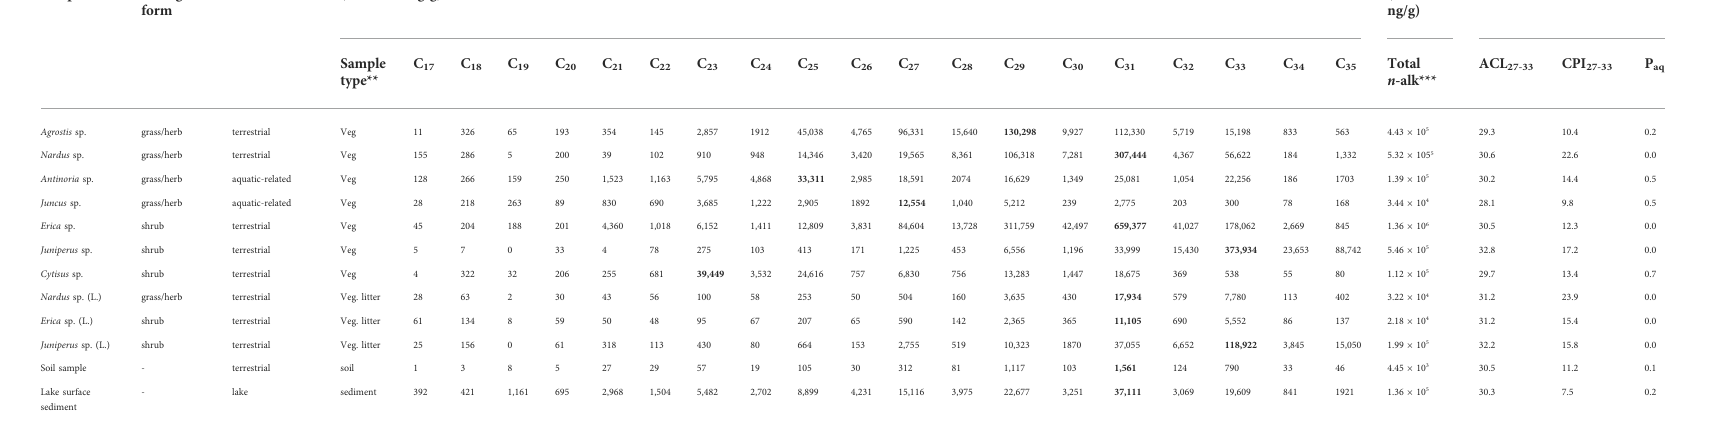
TABLE 1 – n -Alkane concentrations* and indices (ACL 27-33 , CPI 27-33 , P aq ) of plant leaves and stems and soil and surface sediment samples from the Lake Peixão (Serra da Estrela, Portugal). Sample Ecological form